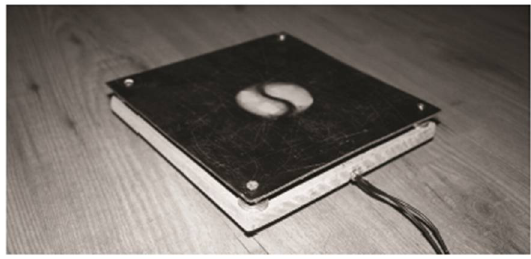
Figure 3. Button system used as a pressure plate to dispense treats [30].